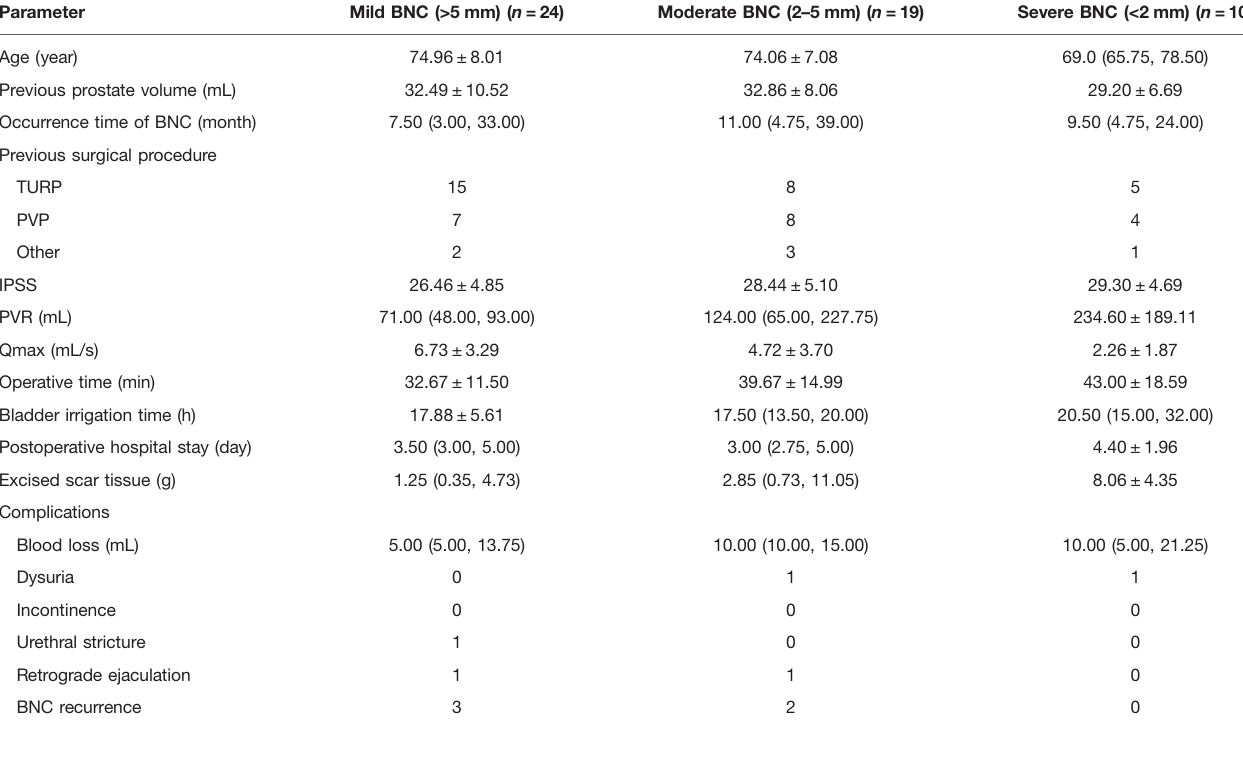
TABLE 1 | Baseline characteristics and perioperative and follow-up results of patients ( n =53). Parameter